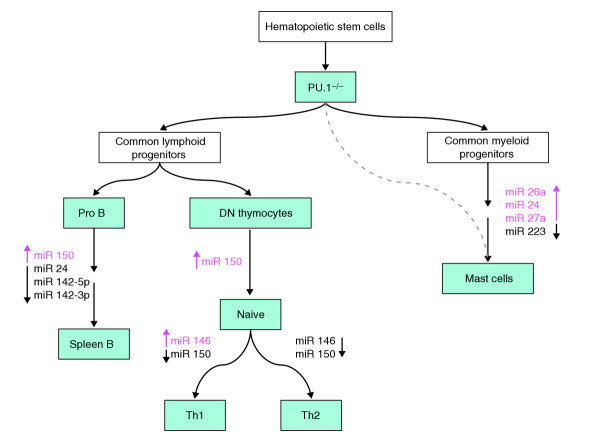
MiRNA expression and lineage commitment. Expression of miRNA in the hematopoietic system changes depending on the differentiation status. Part of the hematopoietic differentiation tree is represented: myeloid and lymphoid progenitors derive from a common progenitor, which is represented by the model Pu.1-/- cell line (see text). The common lymphoid progenitor gives rise to B and T lymphocytes and the common myeloid progenitor gives rise to mast cells and other cells types. Superimposed on this diagram are examples of miRNAs that were discovered to be differentially expressed between the indicated precursor/progeny pairs using array analysis with confirmation by Northern blot. DN, double-negative.